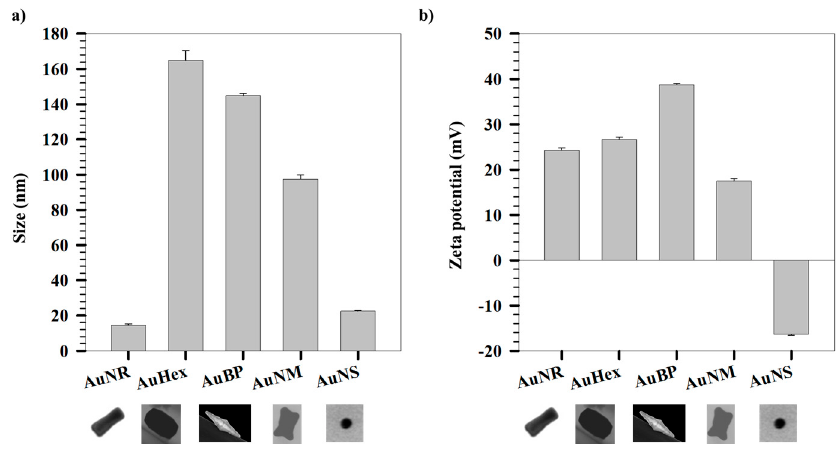
Figure 2. ( a ) Hydrodynamic sizes and ( b ) zeta potentials of different shapes of AuNPs. Table 1. Differences in the sizes obtained from S(T)EM and DLS measurements. The differences can be attributed to measurement principles and the diameters being reported.